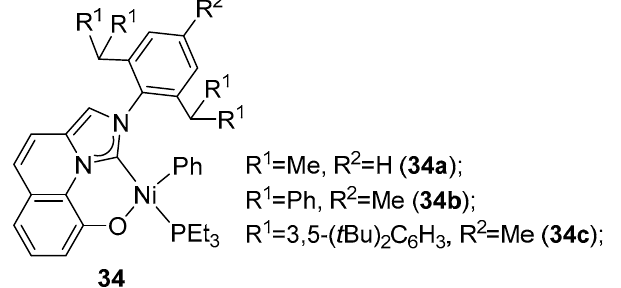
Figure 30. NHCs nickel catalysts 34a – c bearing imidazo [1,5-a]